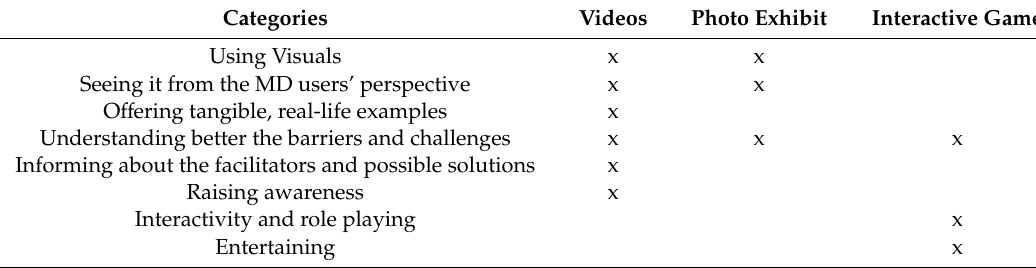
Table 5. Qualitative Descriptive Categories by KM